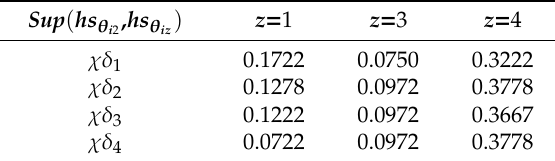
Table 3. Support degree of hs θ